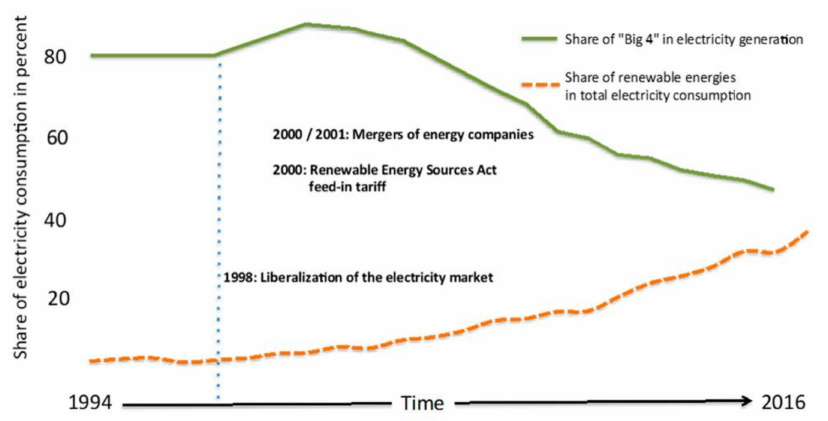
Figure 3. Electricity sector in Germany. Reproduced from [151], Energies: